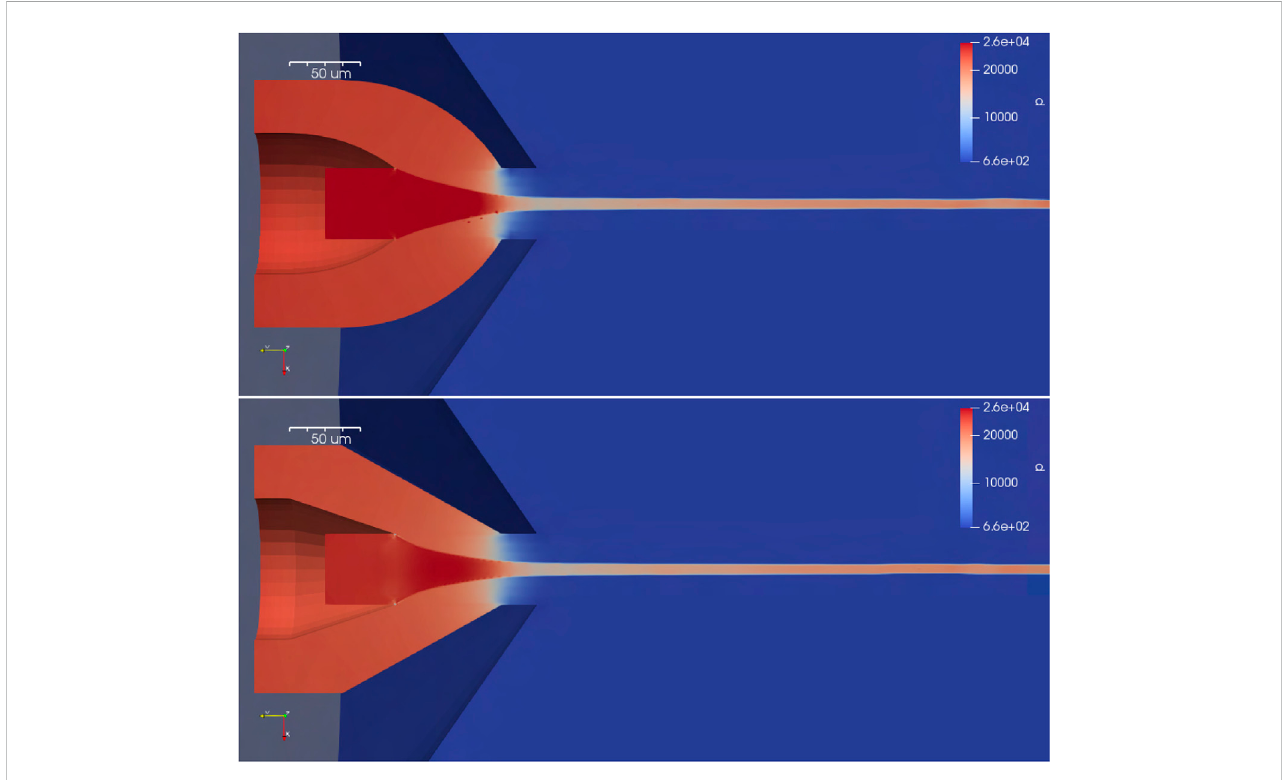
FIGURE 19 Image shows the numerical simulation at a random time-step alongside a random snapshot of the experimental testing of a running jet from the cone- shaped GDVN. For comparison, the two snapshots were chosen to have matching jet lengths; this is not an indication of matching mean jet lengths between numerical and experimental